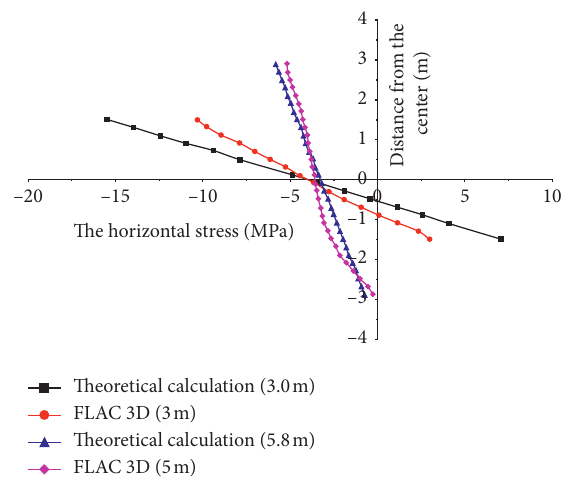
Figure 6: The lateral vertical